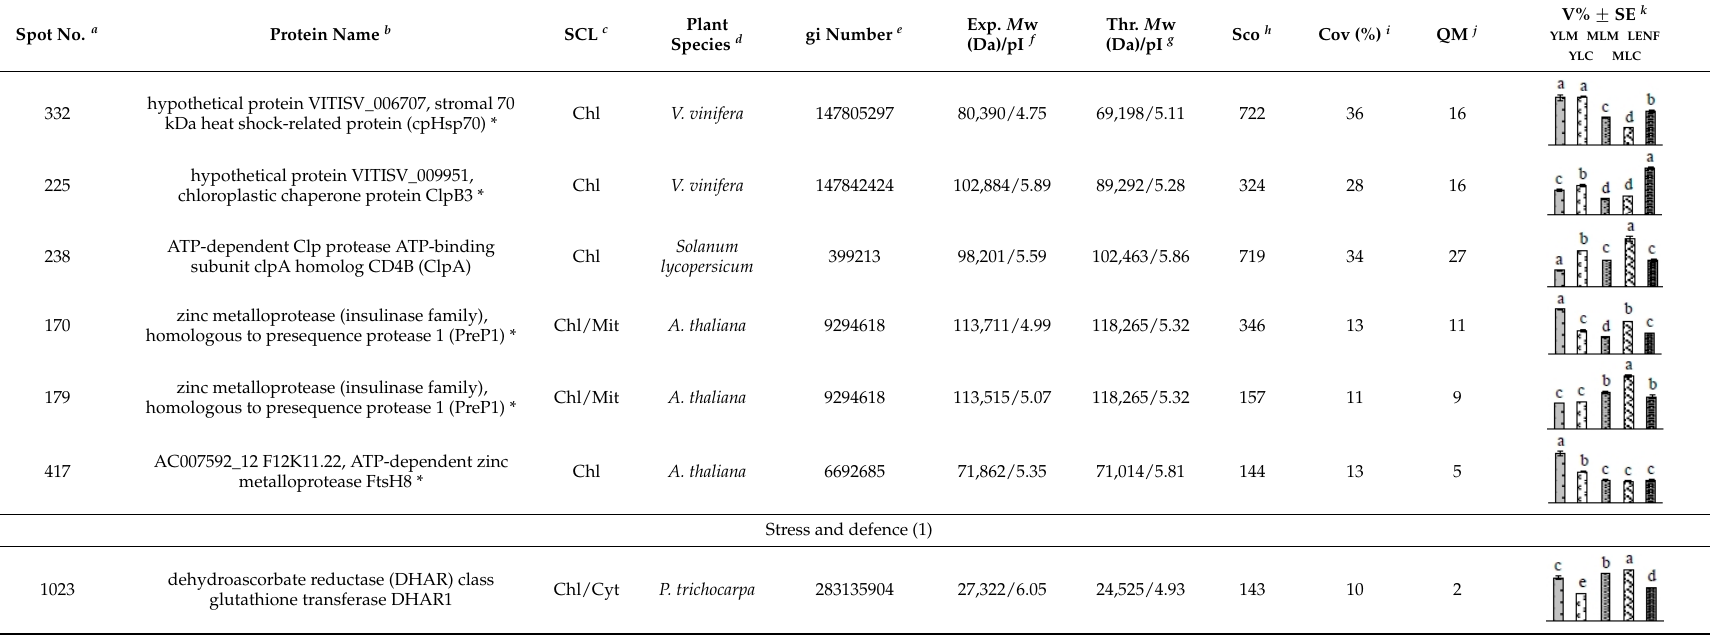
a : Assigned spot number as indicated in Figure 5; b : The name and functional categories of the proteins identified by MALDI TOF-TOF MS. Protein names marked with an asterisk (*) have been edited based on The Basic Local Alignment Search Tool (BLAST) against National Center for Biotechnology Information non-redundant (NCBInr) protein database. The detailed information of the NCBI BLAST can be found in Table S2; c : Protein subcellular localization predicted by software YLoc, LocTree3, Plant-mPLoc, ngLOC, and TargetP. SCL, subcellular location; Chl, chloroplast; Cyt, cytoplasm; Mit, mitochondria; d : The plant species that the peptides matched to; e : Database accession numbers from NCBInr; f , g : Experimental (f) and theoretical (g) molecular weight (Da) and pI of identified proteins. Experimental values were calculated